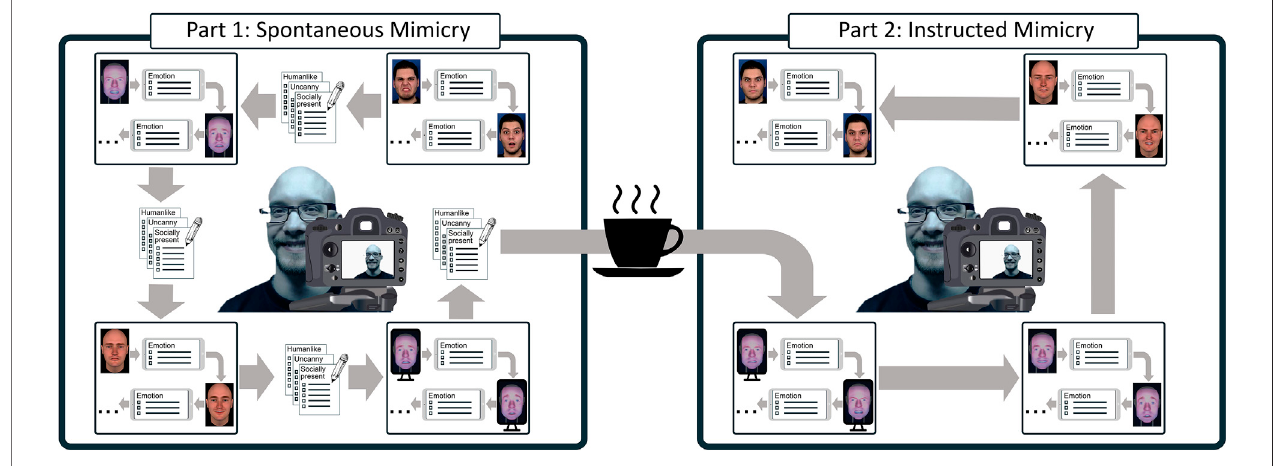
FIGURE 5 | A visualization of the experiment procedure. Note that the order of embodiments as well as the facial expressions were shuf fl ed between the experimental parts and participants to control for the ordering effect. In total, participants saw 12 expressions (2 x 6 emotions) per embodiment in each